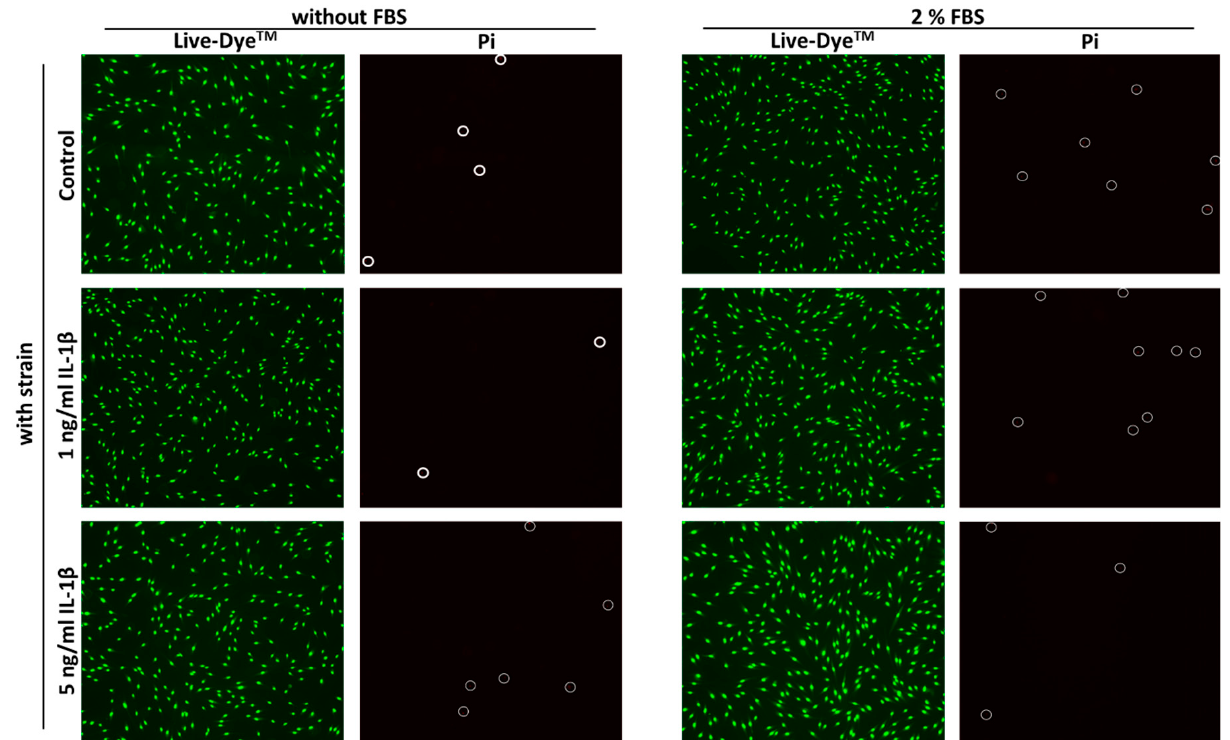
Figure 1. Representative pictures of live/dead staining of hPDL-MSCs after applying static orthodontic tensile forces under IL-1 β -induced inflammatory conditions. After stimulating hPDL-MSCs with 1 ng/mL or 5 ng/mL IL-1 β , STS with 6% equibiaxial elongation was applied in the absence or presence of 2% FBS. Unstimulated and non-stretched hPDL-MSCs served as references. 24 h after applying STS, hPDL-MSCs were doubled-stained with green fluorescent Live-Dye™ (Ex/Em = 488/518 nm) and propidium iodide (Pi) (Ex/Em = 488/515) to discriminate between living (green fluorescent) and dead (red fluorescent) hPDL-MSCs. Red fluorescent dead cells are indicated by white circles. Fluorescence was detected by ECHO Revolve fluorescence microscope using the FITC and Texas Red channels, a 4-fold magnification and an exposure time of 670 ms in both fluorescence channels.